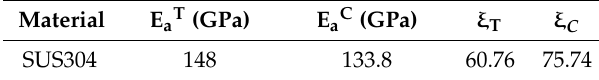
Figure 3. Variation of effective elastic modulus versus plastic strain. Table 2. Measured coefficients of variable elastic modulus.